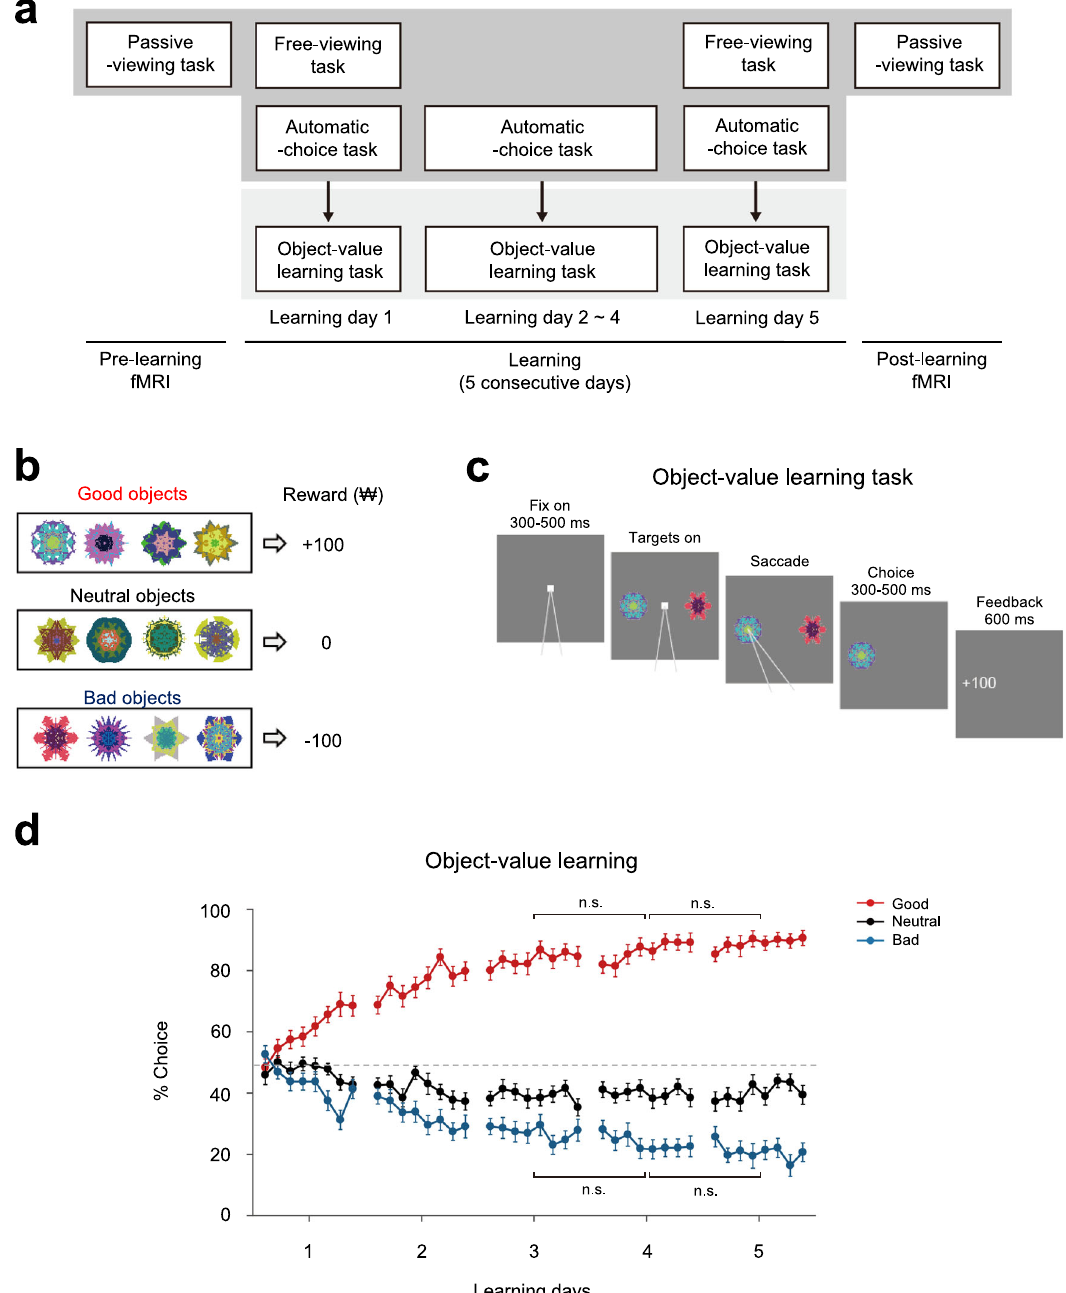
Fig. 1 Experimental design and object-value learning in human subjects. a The experiment comprised separate Pre-learning, Learning, and Post-learning sessions. The Learning session was conducted for 5 consecutive days, during which the participants learned pairings of 24 fractal objects and values. It was composed of free-viewing, automatic-choice, and object-value learning tasks. On learning days 1 and 5 before the other tasks, the free-viewing task was performed. The object-value learning task was conducted every day of the Learning session. The automatic-choice task was conducted just before the object-value learning task on each learning day. Before and after the Learning session, there were Pre-learning and Post-learning fMRI scan sessions. b During the object-value learning task in the Learning session, the participants were trained to associate fractal objects with monetary gain (good; + ₩ 100), monetary loss (bad; − ₩ 100), or neither a gain nor a loss (neutral; ₩ 0). c During each trial of the object-value learning task, a white fi xation square was followed by the presentation of two fractal objects. The participants were instructed to choose the better of the two objects by making a saccade. The choice phase was followed by a feedback phase showing the outcome (gain, loss, or nothing) earned for that trial. d The choice ratio of the objects associated with a good, neutral, or bad value during the object-value learning task. There was an increase of the ratio of choosing good objects as learning proceeded over days during the object-value learning task, while the ratio of choosing neutral or bad objects decreased ( n = 26 participants, three- way ANOVA with value, day, and bin as factors, *** p = 1.241 × 10 − 27 for value X day; two-way ANOVA with day and bin as factors for the good objects, *** p = 8.956 × 10 − 23 for day; post hoc Bonferroni pairwise comparison, *** p = 5.770 × 10 − 9 , between days 1 and 2 for good objects, ** p = 4.230 × 10 − 4 , between days 2 and 3 for good objects, n.s. not signi fi cant). Error bars indicate between-subjects s.e.m.